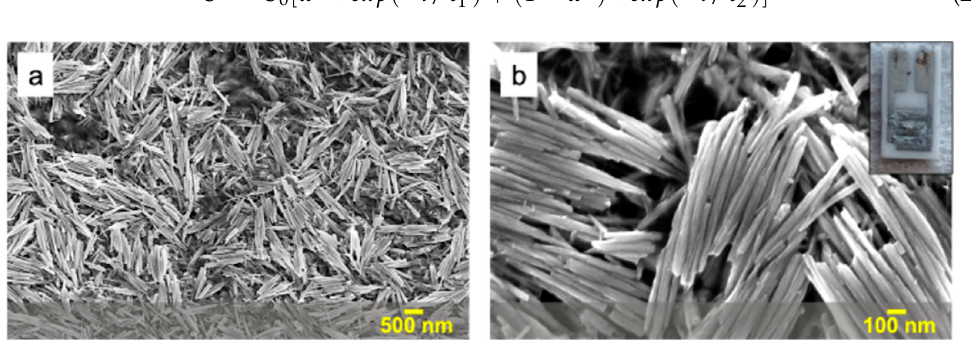
Figure 1. Low- ( a ) and high-magnification ( b ) SEM images of WO 3 nanorods deposited onto an interdigitated electrode (inset).